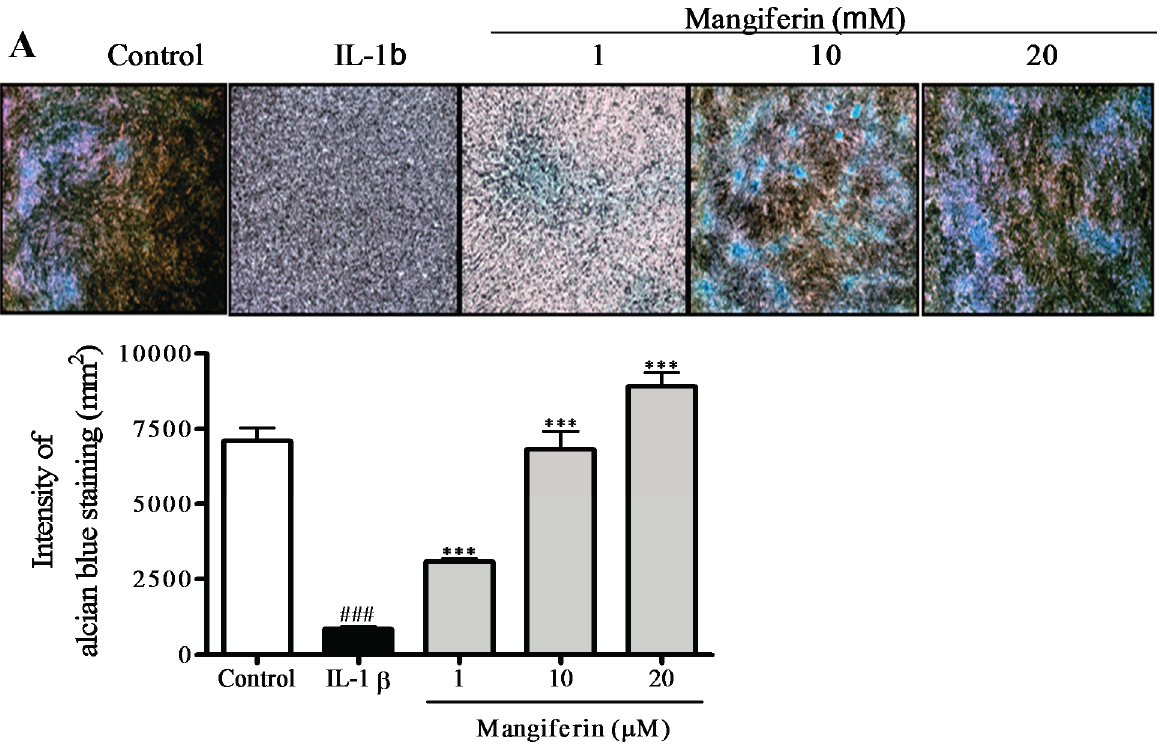
mesenchymal stem cells (MSCs). ( A ) Histological analysis of mangiferin by alcian